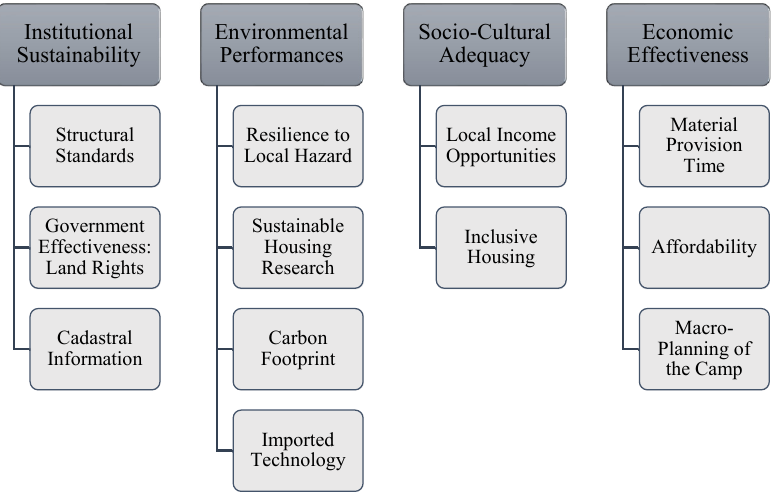
Figure 11. Categories: The structure ‐ related issues and challenges.